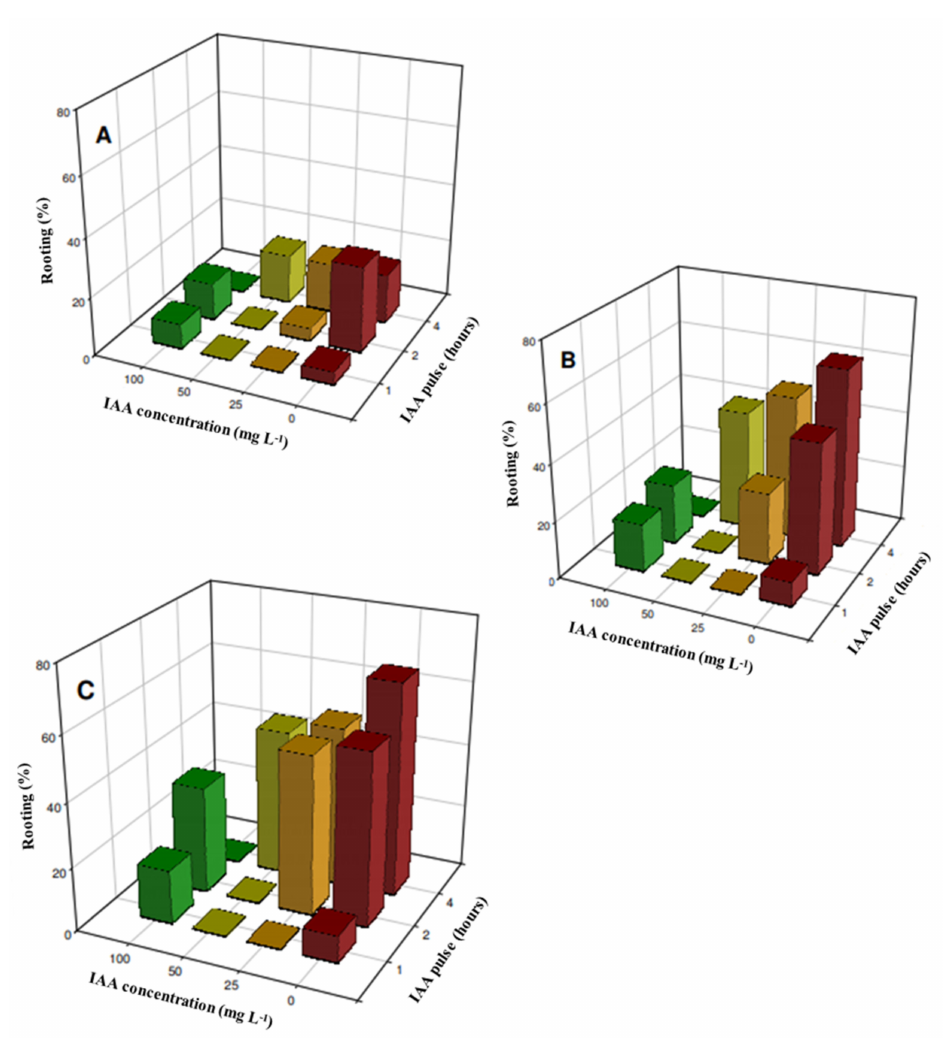
Figure 3. Pulse treatments performed to test the effects on rooting of Tetraclinis articulata (Vahl) Masters shoots cultured in vitro. Four concentrations (0, 25, 50, and 100 mg L − 1 ) of IAA and three dipping times (1, 2, and 4 h) in liquid medium composed by SH salts, vitamins, and 250 mg of 2-(N-morpholino)ethanesulfonic acid (MES) were tested in dark conditions. After the pulse treatment, explants were transferred to SH basal medium supplemented with 30 g L − 1 sucrose, 6.6 g L − 1 agar, and 0.5 g L − 1 AC. Rooting percentage was measured ( A ), 6 ( B ), and 8 ( C ) weeks of